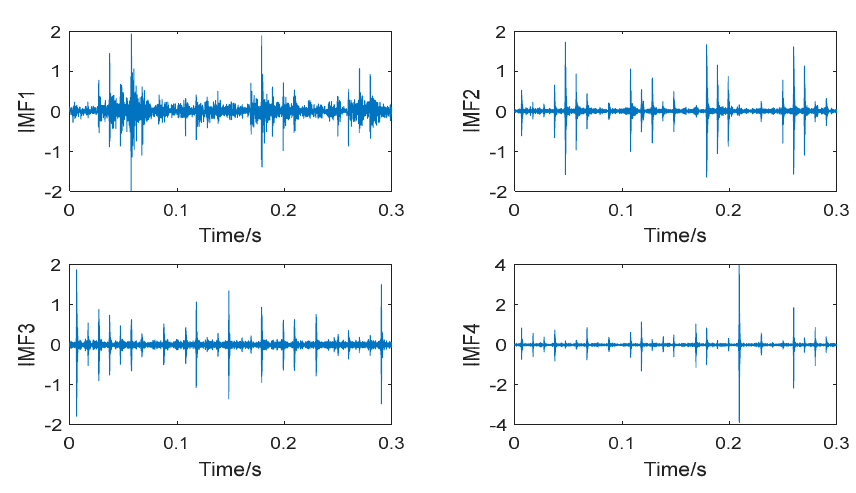
Figure 12. Inner ring defect state signal VMD.